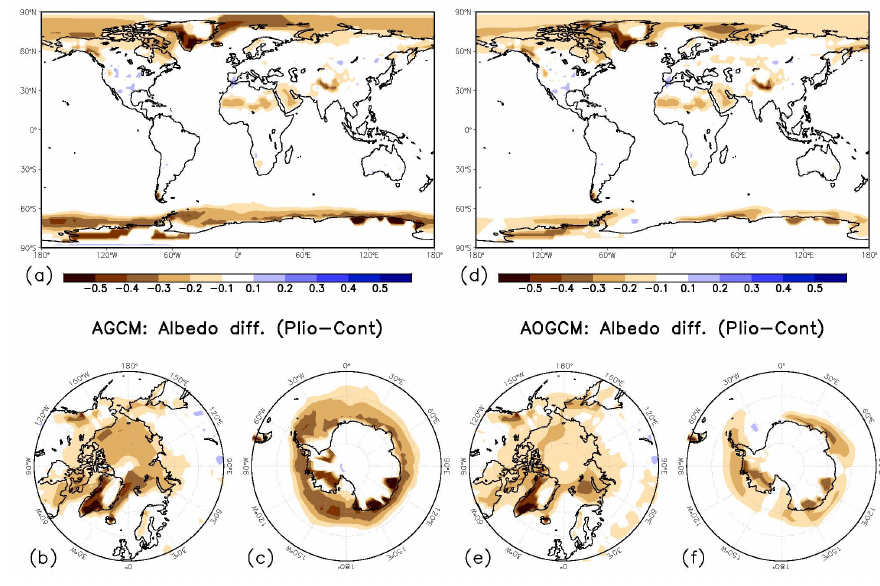
Fig. 11. Difference between the annual mean surface albedos in the mid-Pliocene and control experiments. AGCM results are shown on the left (a–c) and AOGCM results on the right (d–f) . The polar regions are also shown at the bottom (b, c, e, f)